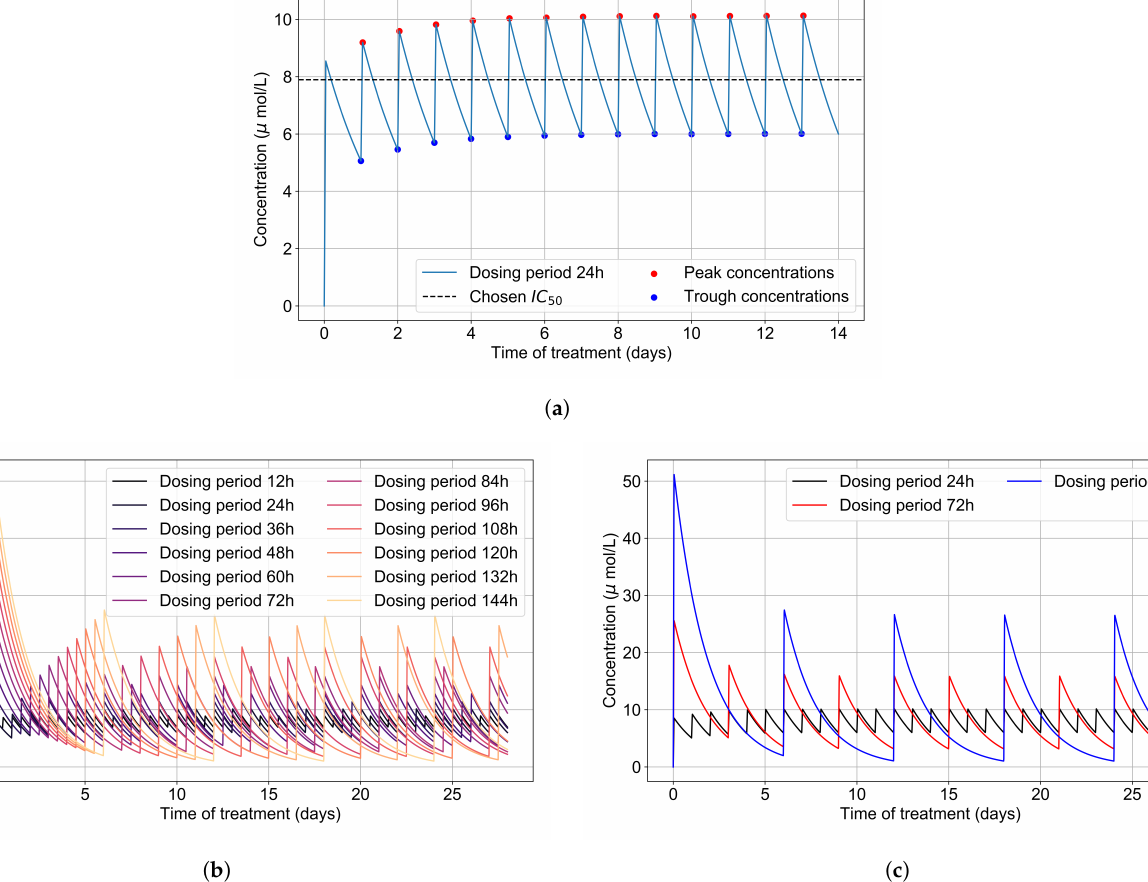
Figure 3. ( a ) Concentration of GS-443902 (remdesivir’s active metabolite) for a 14 day treatment with a 200 mg loading dose and 100 mg subsequent daily doses (IV infusion) is obtained by solving Equations (1a) and (1b). Concentration peaks (red) and troughs (blue) are pointed out, and their mid-point (dashed line) is our base IC 50 . ( b ) Concentrations of the active metabolite, GS-443902, in PK simulations for the different dosing regimens of remdesivir, with the doses rescaled to keep the total average amount of remdesivir given over 24 h constant. ( c ) Some selected PK profiles from ( b